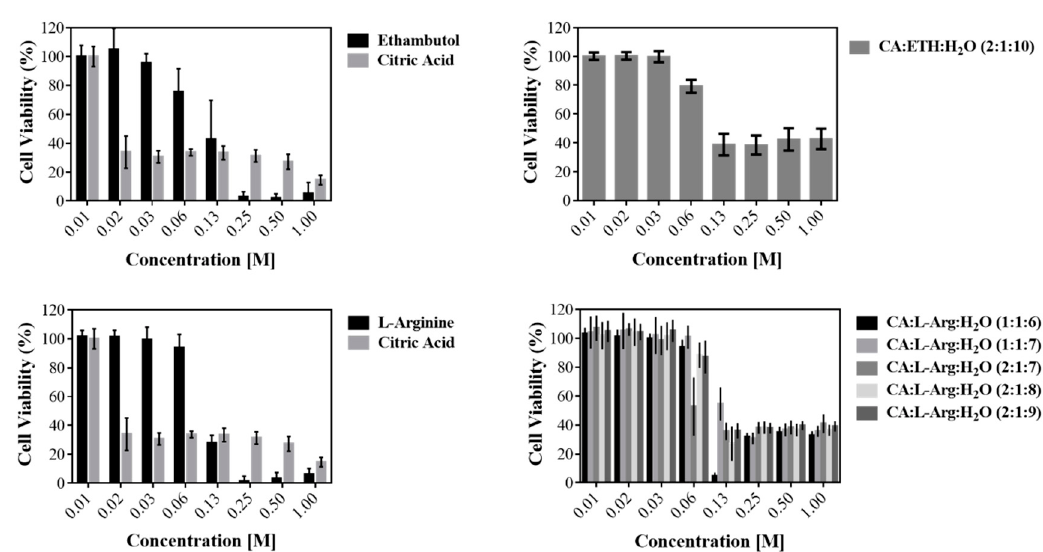
Figure 5. Cell viability (%) measured in Caco-2 cell line, in THEDESs and raw materials.